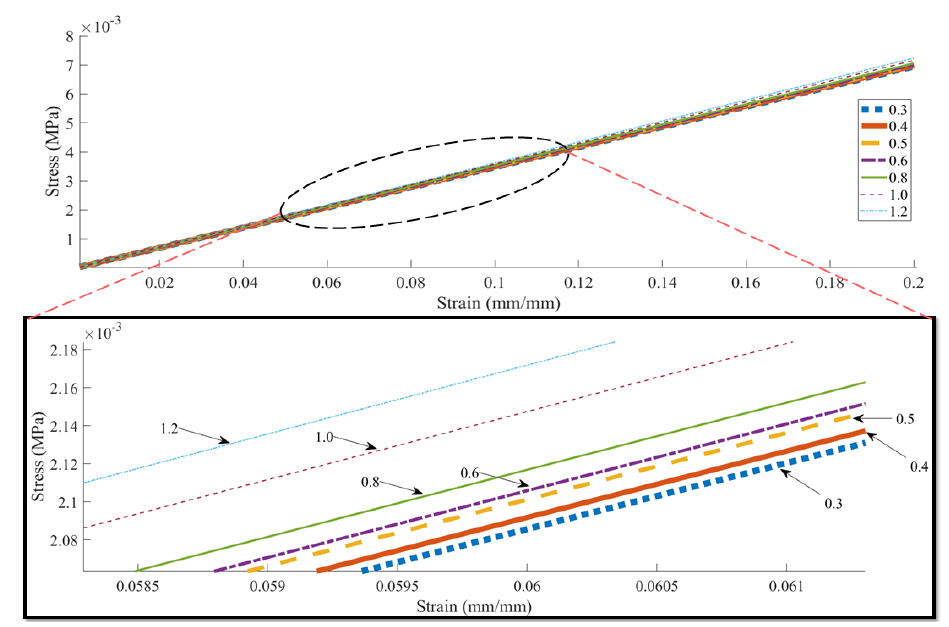
Figure 4. Mesh sensitivity study.